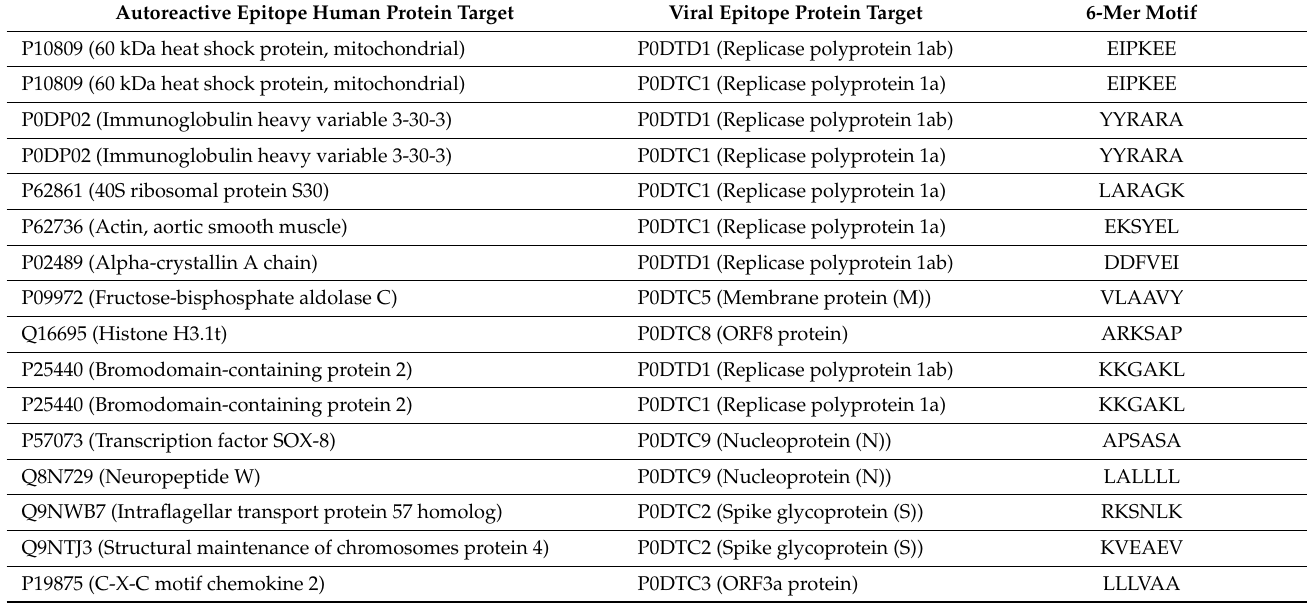
Table 6. Matching 6-mer linear motifs found in epitopes against SARS-CoV-2 viral proteins that are also present in MS-associated autoreactive epitopes that target “self”